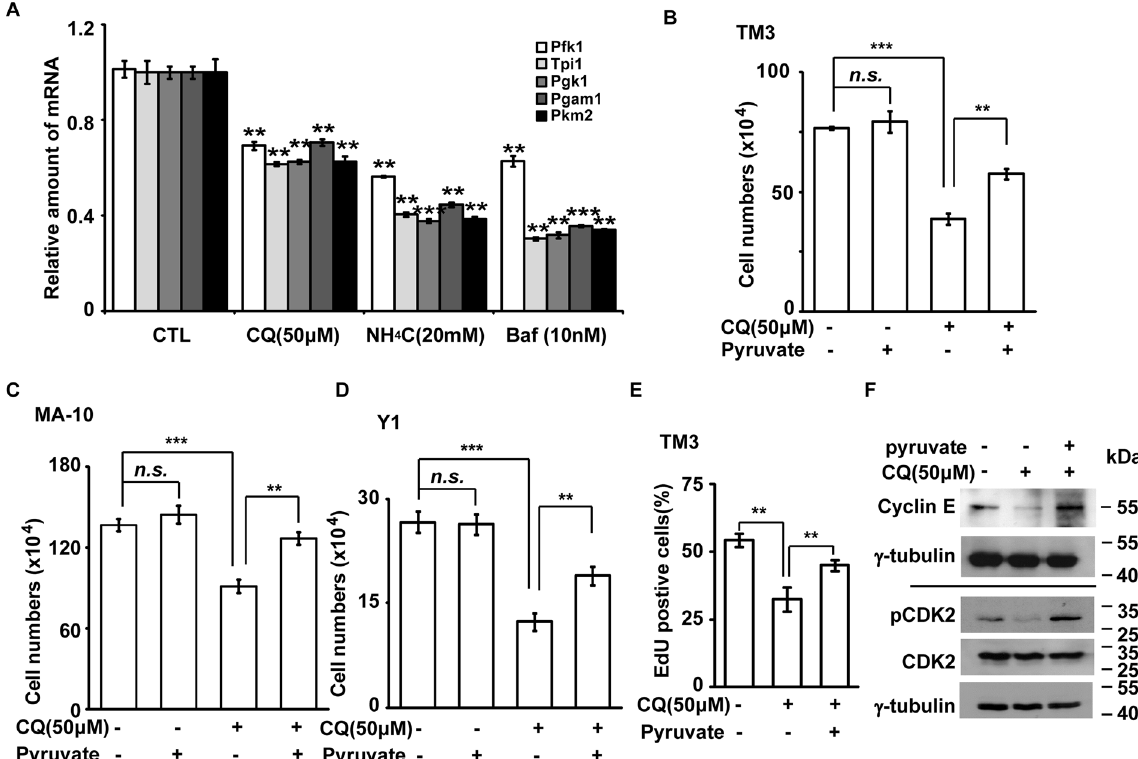
Figure 5. Glycolytic gene expression is reduced by treating cells with lysosomal inhibitors. ( A ) Glycolytic gene expression is reduced by treating cells with lysosomal inhibitors. Quantitation of glycolytic gene expression in lysosomal inhibitors-treated Y1 cells (CQ: 50 μ M; NH 4 Cl: 20 mM; Baf: 10 nM). CTL: control; CQ: chloroquine; Baf: bafilomycin A1. (B-D) Pyruvate rescues cell growth in CQ (50 μ M)-treated TM3 ( B ), MA-10 ( C ), and Y1 ( D ) cell lines. ( E ) Pyruvate promotes S phase entry in CQ (50 μ M)-treated TM3 cells. ( F ) Pyruvate restores cyclin E1 expression and CDK2 activation. Whole cell extracts of Y1 cells treated with or without CQ (50 μ M) in the presence or absence of pyruvate are analyzed by immunoblot with antibodies against cyclin E1, phosphorylated CDK2 at Thr160 (pCDK2) and γ -tubulin. n.s.: no significance; * P < 0.05; ** P < 0.01; *** P <